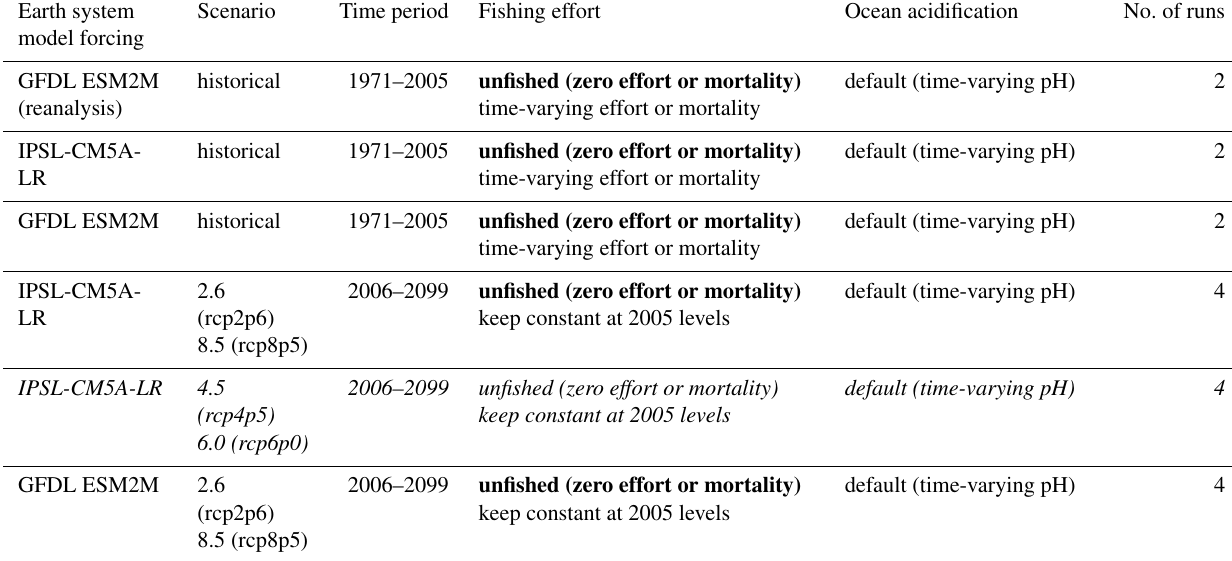
Table 6. All experiments (historical and future, standardized, and optional) for the global and regional fisheries and marine ecosystem models participating in the first round of Fish-MIP. Runs in bold are prioritized (Tier 1), those in roman preferred but optional (Tier 2), and those in italics optional (Tier 3); this is to allow modellers with limited computational resources to participate and prioritize. Note that the CMIP5-based runs (non-reanalysis) are continuous from historical into the future, reducing the total number of